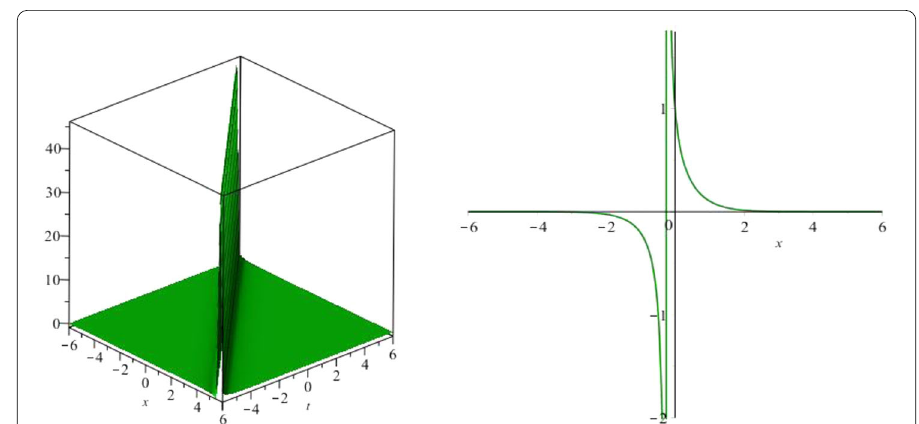
Figure 3 3D plot for φ 13 at y = 1 with σ = μ = k = δ = 1 and 2D at t = 0